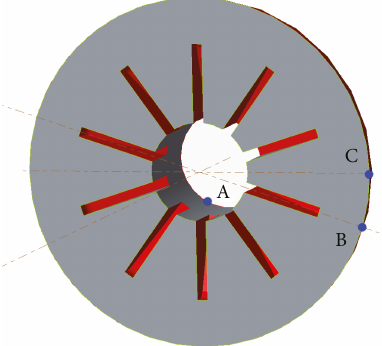
Figure 10: Positions of the 3 measured points.